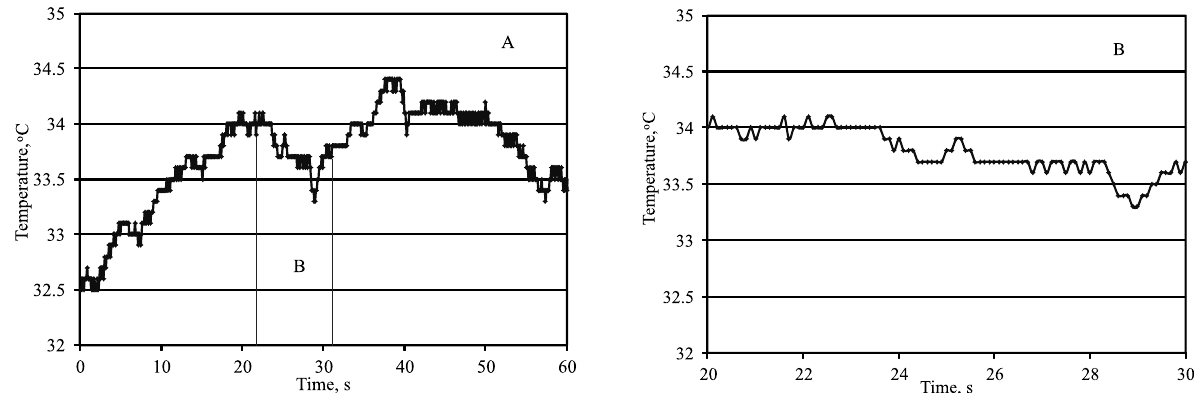
Figure 4. Temperature fluctuations in a plant leaf during the sunny period of the day under natural environmental conditions. Wind speed v m = 1.1